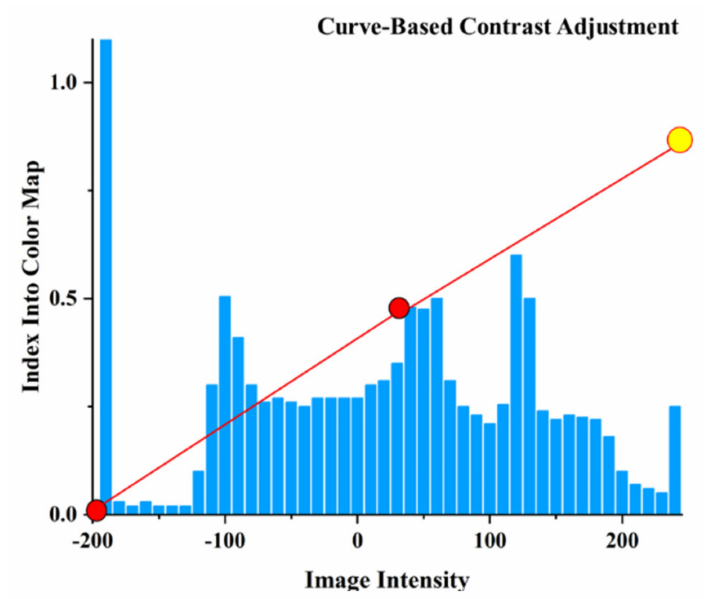
Figure 5. Image intensities mean, range, and distribution histogram of the lesion and liver area shown in the program (the red line and markers are used to adjust the view screen, which can be used to adjust the display intensity of each image